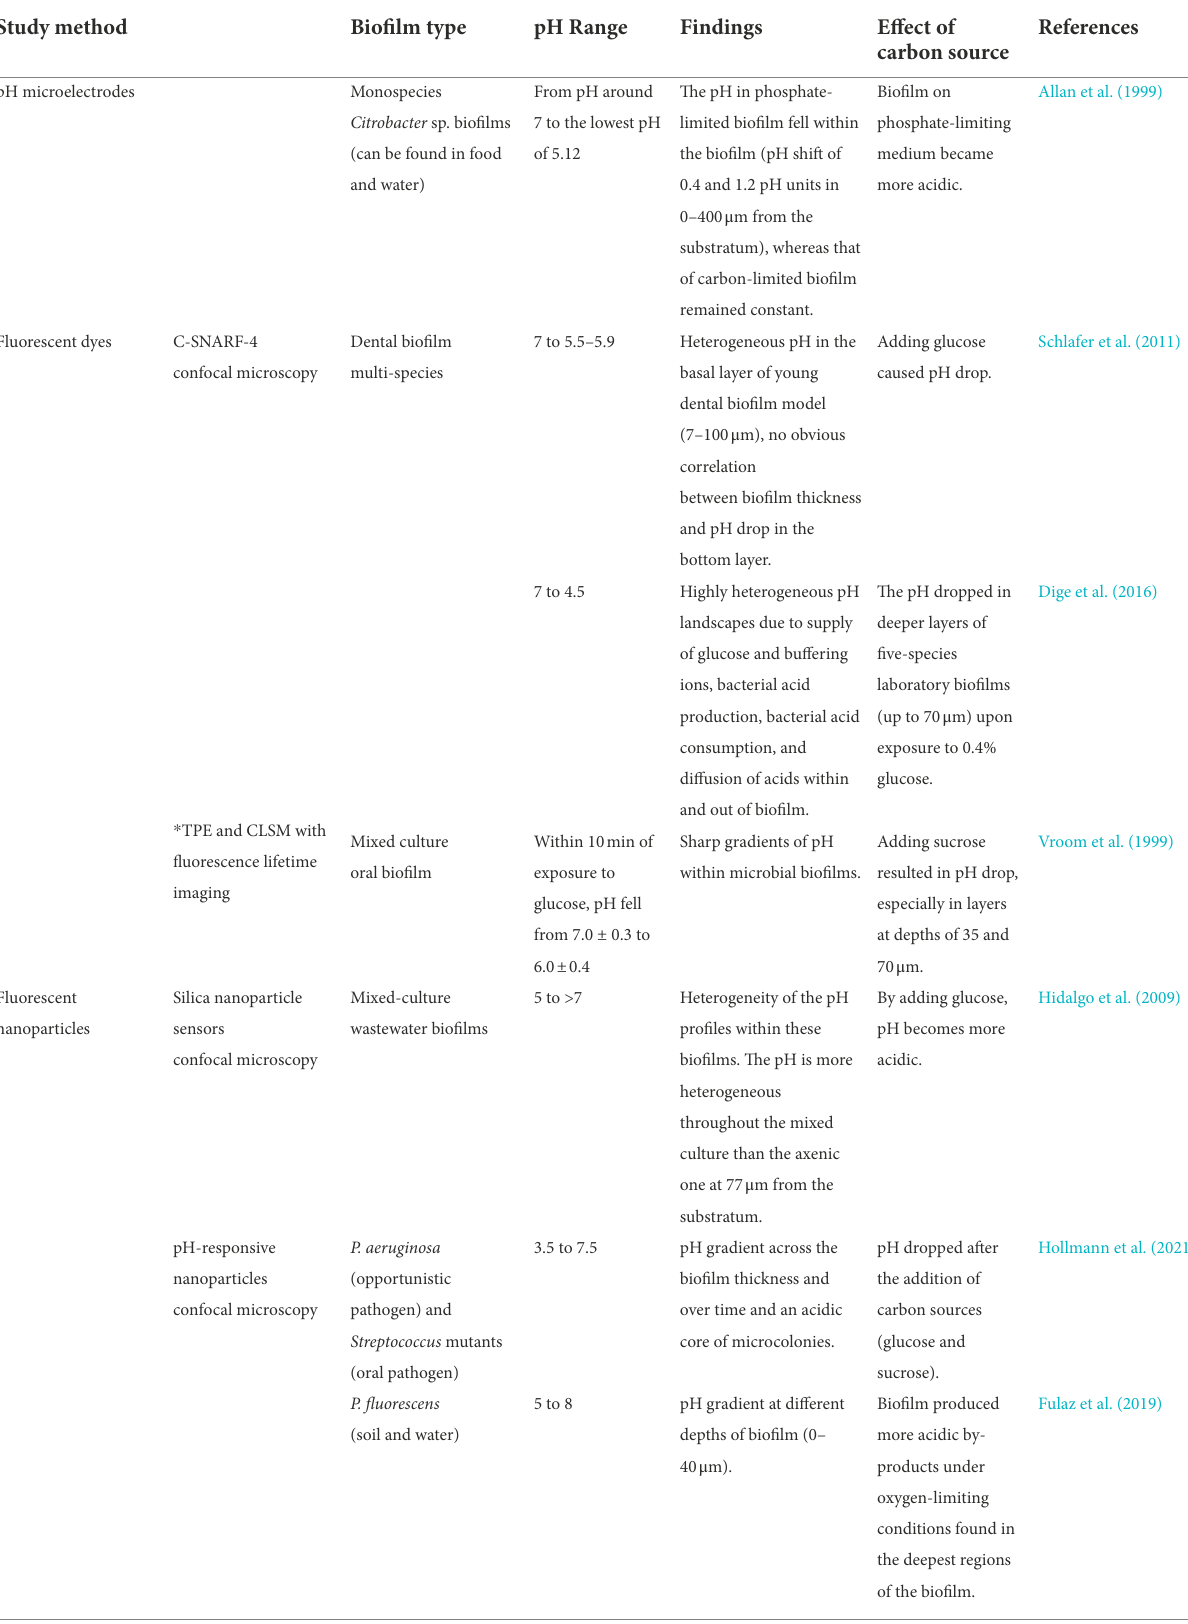
TABLE 2 Studies on pH gradient in biofilm and the effect of carbon